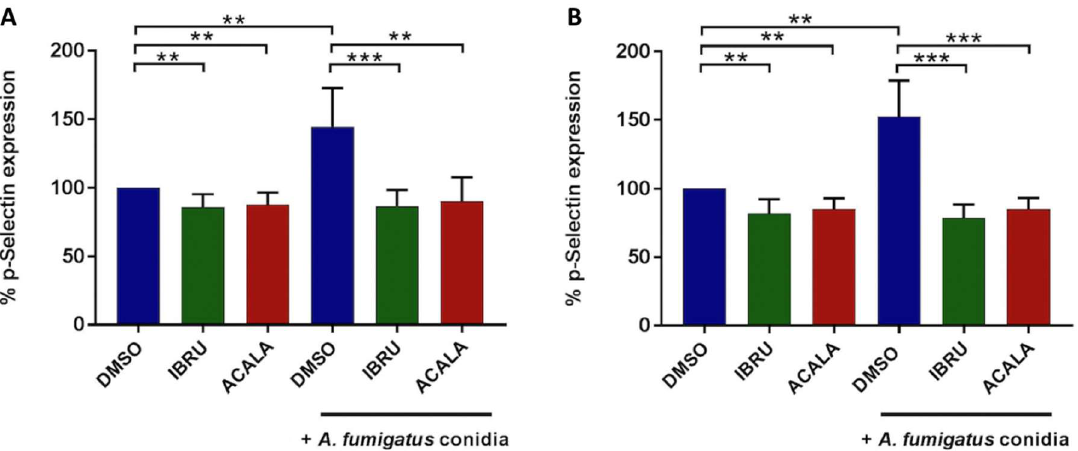
Figure 3. In vitro effects of ibrutinib and acalabrutinib on platelets’ degranulation in response to A. fumigatus conidia. Platelet-rich plasma (PRP) from healthy volunteers ( A ) and treatment-naïve CLL patients ( B ) was treated with 1 µM ibrutinib (IBRU), acalabrutinib (ACALA), or vehicle (DMSO) for 1 h at 37 °C and stimulated or not stimulated with A. fumigatus conidia at an effector-to-target (E:T) ratio of 100:1 for 30, 60, 90, 120, 180, or 270 min. Platelet activation was detected by flow cytometry, labeling samples with PE-conjugated anti-CD42b antibody, a surface marker constitutively expressed on platelets, and with an FITC-conjugated anti-CD62P/P-selectin antibody, a marker of alpha granule secretion. Results are reported as percentages of CD62b expression normalized on DMSO-treated unstimulated platelets (** p < 0.01; *** p < 0.001).